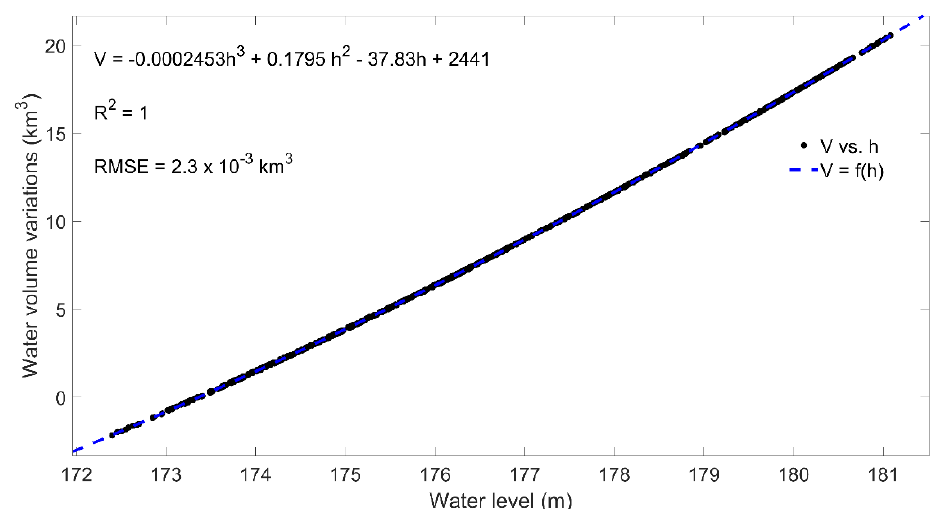
Figure A1. Third-order polynomial fit between altimetry-based water level and water volume FigureA1. variations.